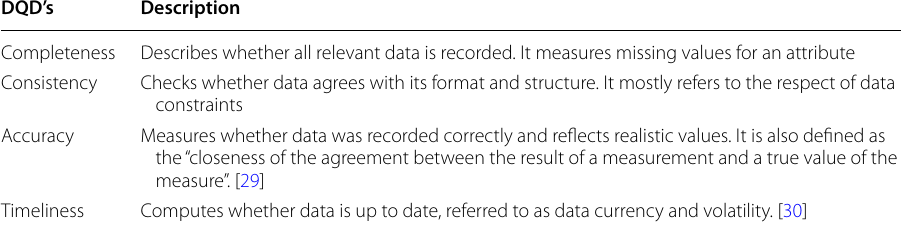
Table 1 Example of data quality dimensions